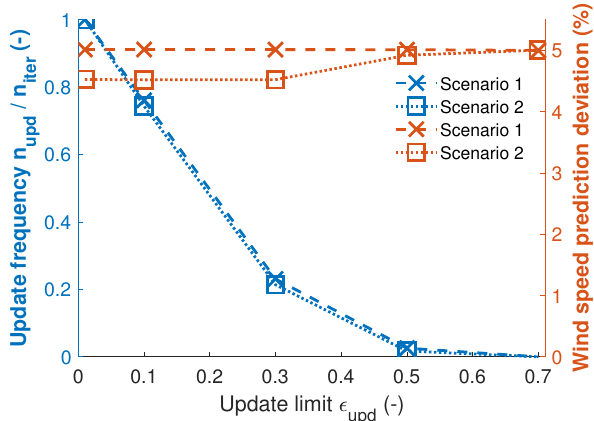
Figure 7. Impact of matrix update limit on downstream turbine wind speed prediction accuracy (right) and matrix update frequency